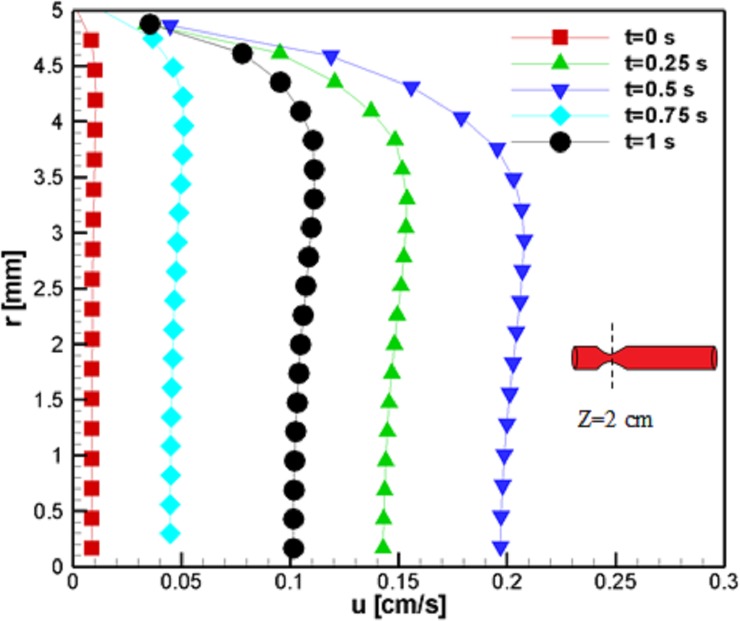
Profile of the axial velocity at z = 2 cm for the case without Joule heating at five different time instances, Lvessel = 7 cm, Rvessel = 1 cm and fifty percent stenosis.